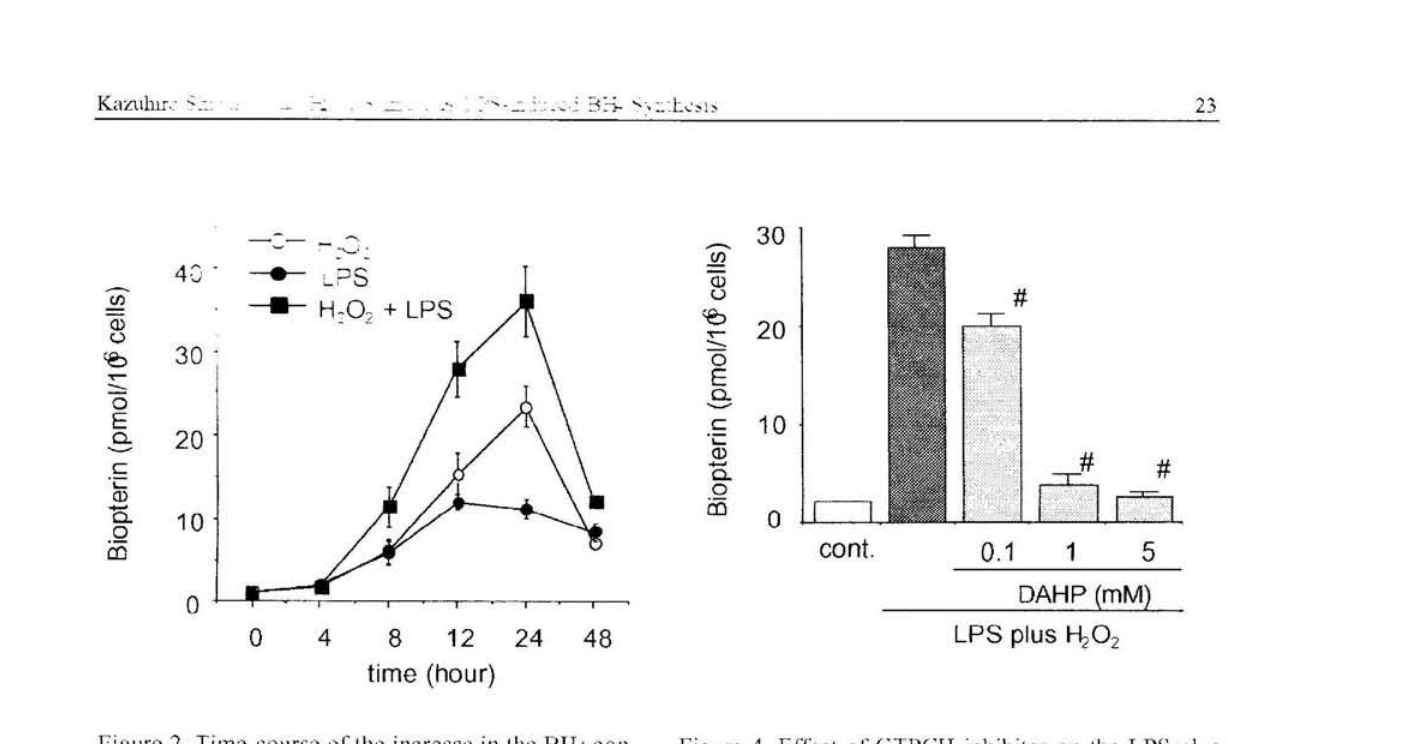
Figure 2. Time-course of the increase in the BII4 con- tent by LPS, hydrogen peroxide and LPS plus hydro- gen peroxide. The cells were incubated with hydrogen peroxide (100 111M). LPS (100 ng/ml) or LPS (100 ng/ml) plus hydrogen peroxide ( 100 mM). At the indi- cated times, the BLU contents were determined. Values are the means ± S.L.M. of 4 experiments.